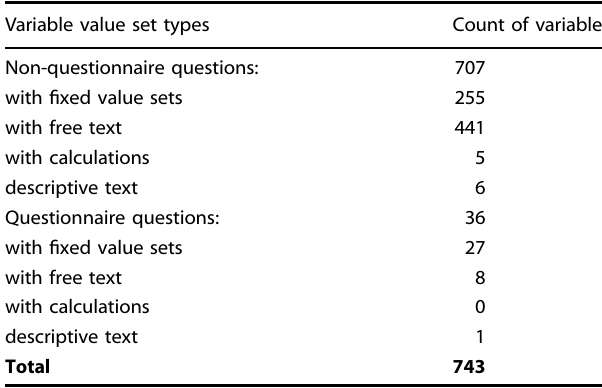
Table 4. Overview of all common variables identi fi ed as core data elements for the ORCHESTRA core data set.